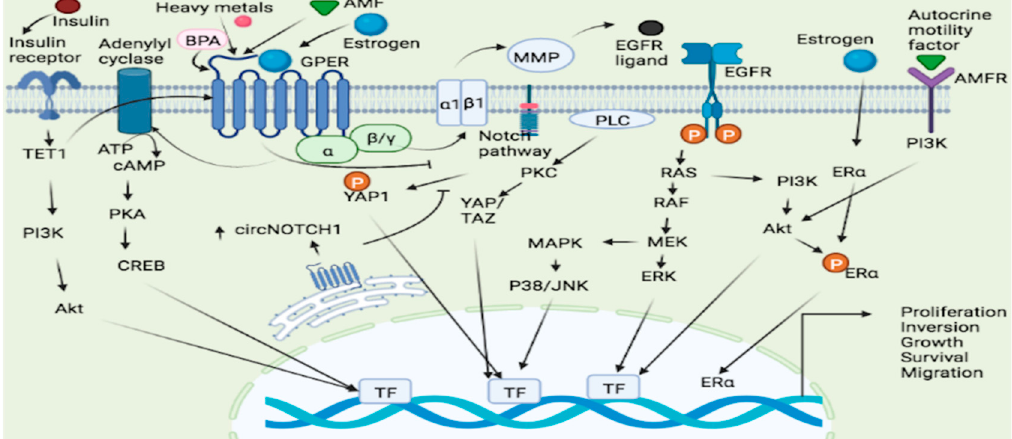
Figure 2. GPER signaling pathways in lung and endometrial cancer. Several ligands such as Estrogen, heavy metals and AMF bind to the GPER leading to the activation and subsequent cellular proliferation, inversion, growth and survival via the GPER/cAMP/PKA/CREB, GPER/RAS/RAF/MEK/ERK and GPER/ERs/ERK/MAPK pathways. Estrogen may also bind to both ER and GPER and generated a signal which leads to increased cell proliferation. GPER-1 interacts with AMF and promotes PI3K signaling resulting in cancer cell growth. TET1 played a key role in upregulating GPER expression and also activating the PI3K/AKT signaling pathway, thus making insulin as a stimulator of EC cell proliferation through TET1-mediated GPER upregulation. ATP = Adenosine Triphosphate, cAMP = cyclic Adenosine monophosphate, YAP = Yes-Associated Protein, PKA = protein Kinase A, PKC = Protein Kinase C, Akt = Protein Kinase B, AMF = Autocrine Motility Factor, AMFR = Autocrine Motility Factor Receptor, ERK = extracellular signal-regulated protein kinase, CREB = cAMP response element binding protein, BPA = Bisphenol A, MAPK = Mitogen-activated protein kinase, PI3K = phosphatidyl inositol 3-kinase, TET1 = tet methyl cytosine dioxygenase 1, RAF = Rapidly Accelerated Fibrosarcoma, RAS = rat sarcoma, MEK = mitogen-activated protein kinase kinase, ERK = Extracellular signal-Regulated Kinase, EGFR = Epidermal growth factor receptor, JNK = c-JUN N-terminal kinase, ER α = Estrogen receptor α